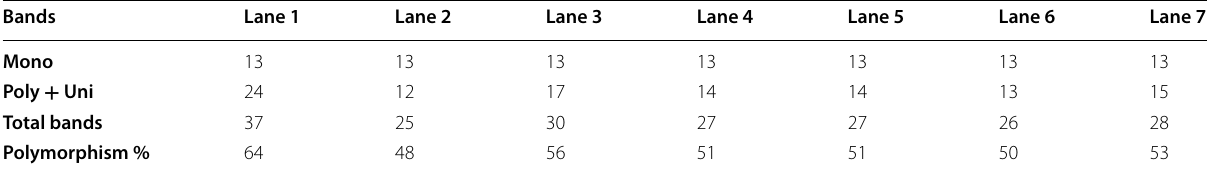
Table 7 AFLP‑PCR amplification products of DNA extracted from regenerated plants and its doner plant sample of longan ( Dimocarpus longan